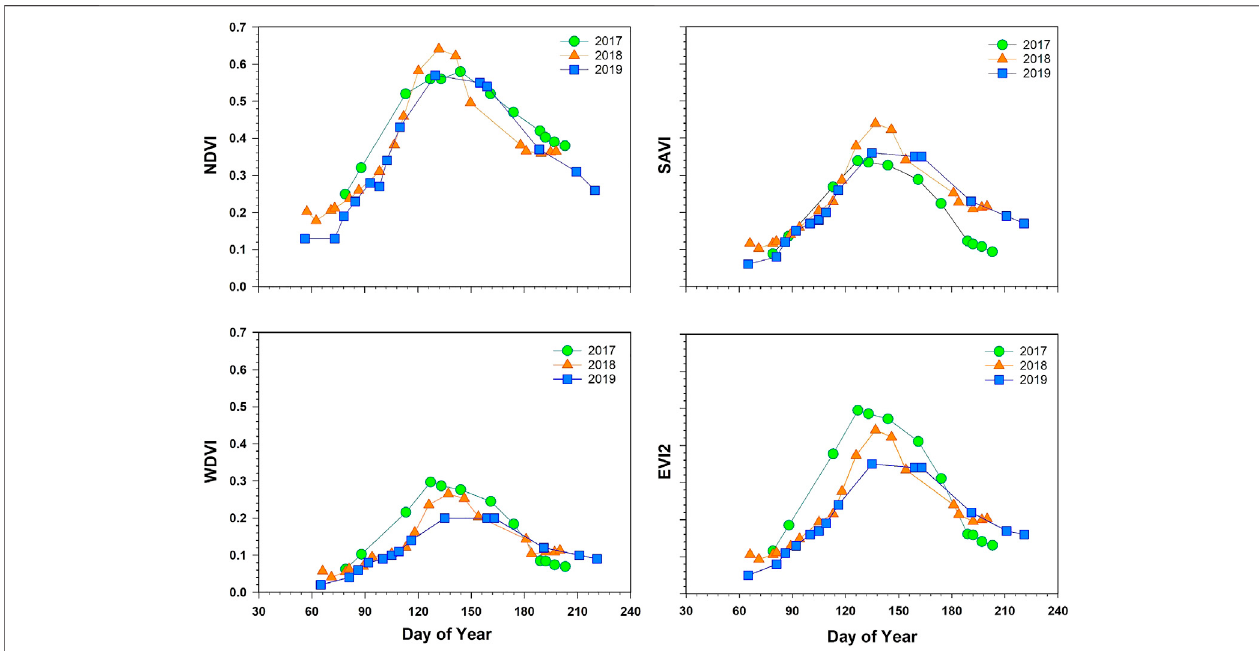
FIGURE 2 | Seasonal progression of vegetation indices over the growing seasons in 2017, 2018, and 2019 for a dryland maize fi eld located near College Station, Texas, United States. Vegetation indices include the normalized difference vegetation index (NDVI), the soil adjusted vegetation index (SAVI), the weighted difference vegetation index (WDI), and the enhanced vegetation index 2